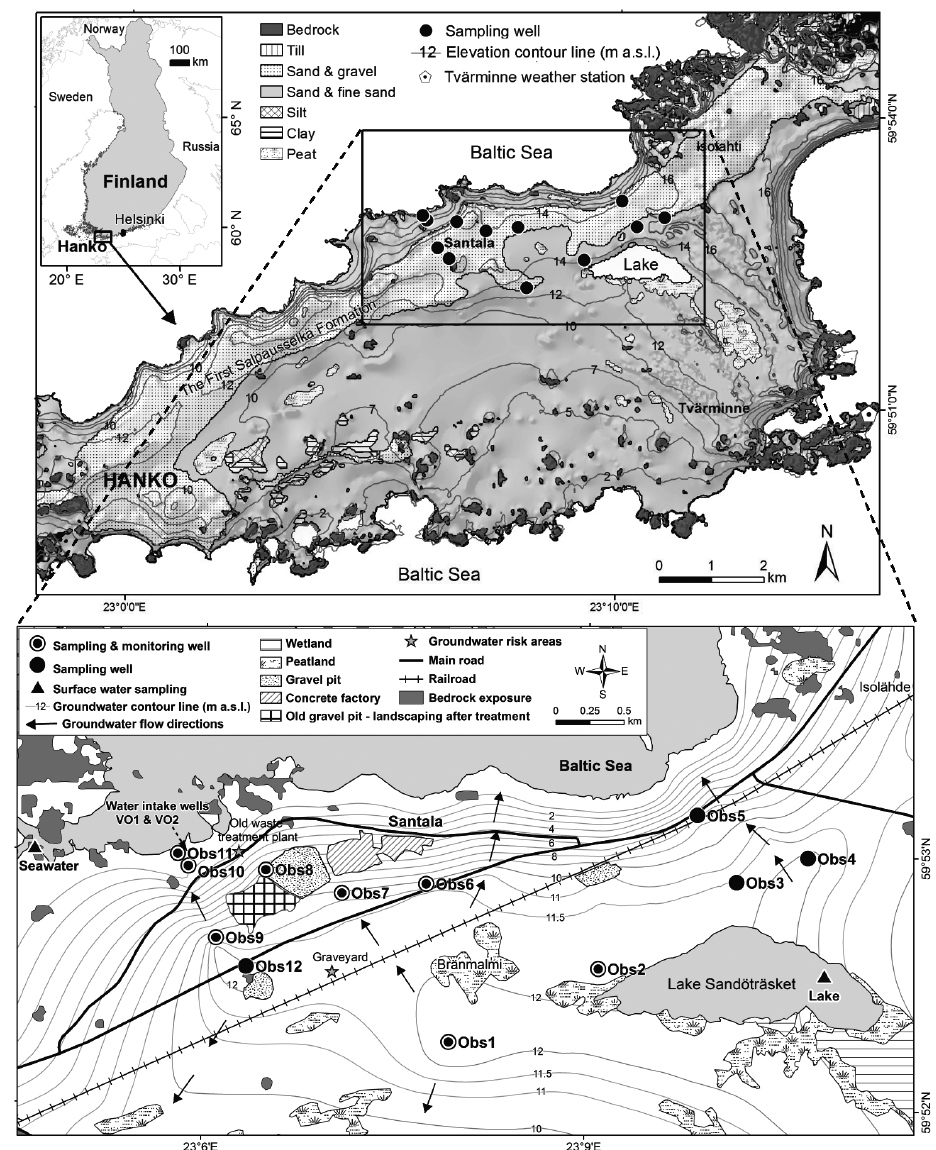
Figure 1. Location and Quaternary geological deposit map of the study area in the eastern Baltic Sea